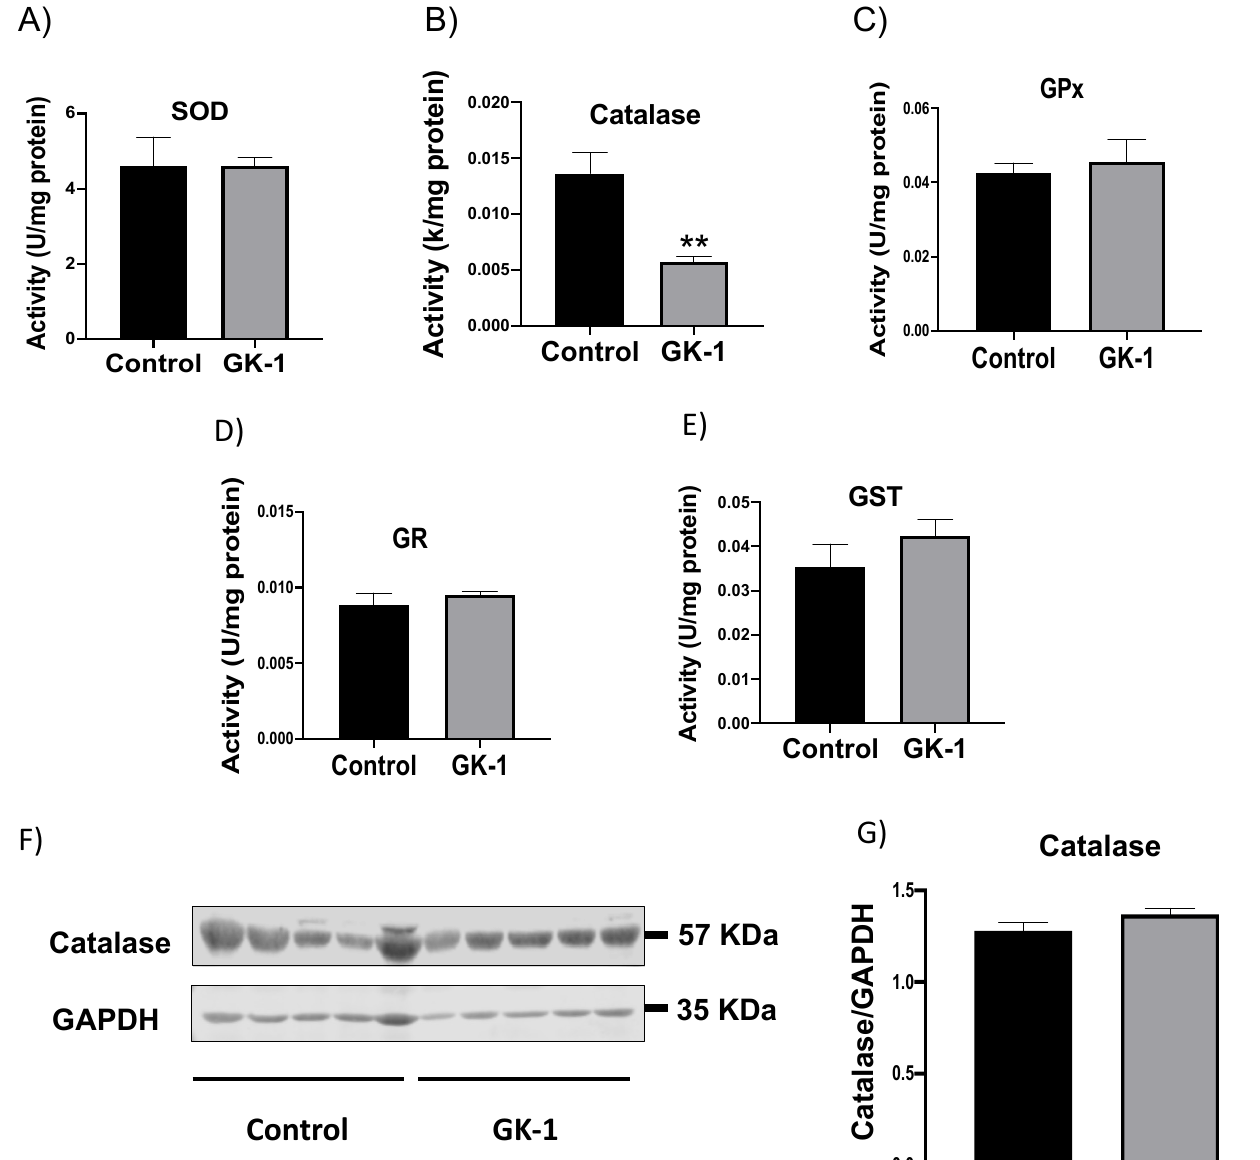
Figure 2. GK-1 inhibits the enzymatic activity of catalase. Enzymatic activity of ( A ) superoxide dismutase (SOD), ( B ) catalase, ( C ) glutathione peroxidase (GPx), ( D ) glutathione reductase (GR), ( E ) glu- tathione S-transferase (GST). ( F ) Representative immunoblotting and ( G ) densitometric analysis of catalase expression. Glyceraldehyde 3-phosphate dehydrogenase (GAPDH) was used as the loading control. t -Student test, control vs. GK-1, ** p < 0.005. Data are expressed as the mean ± SEM, n =